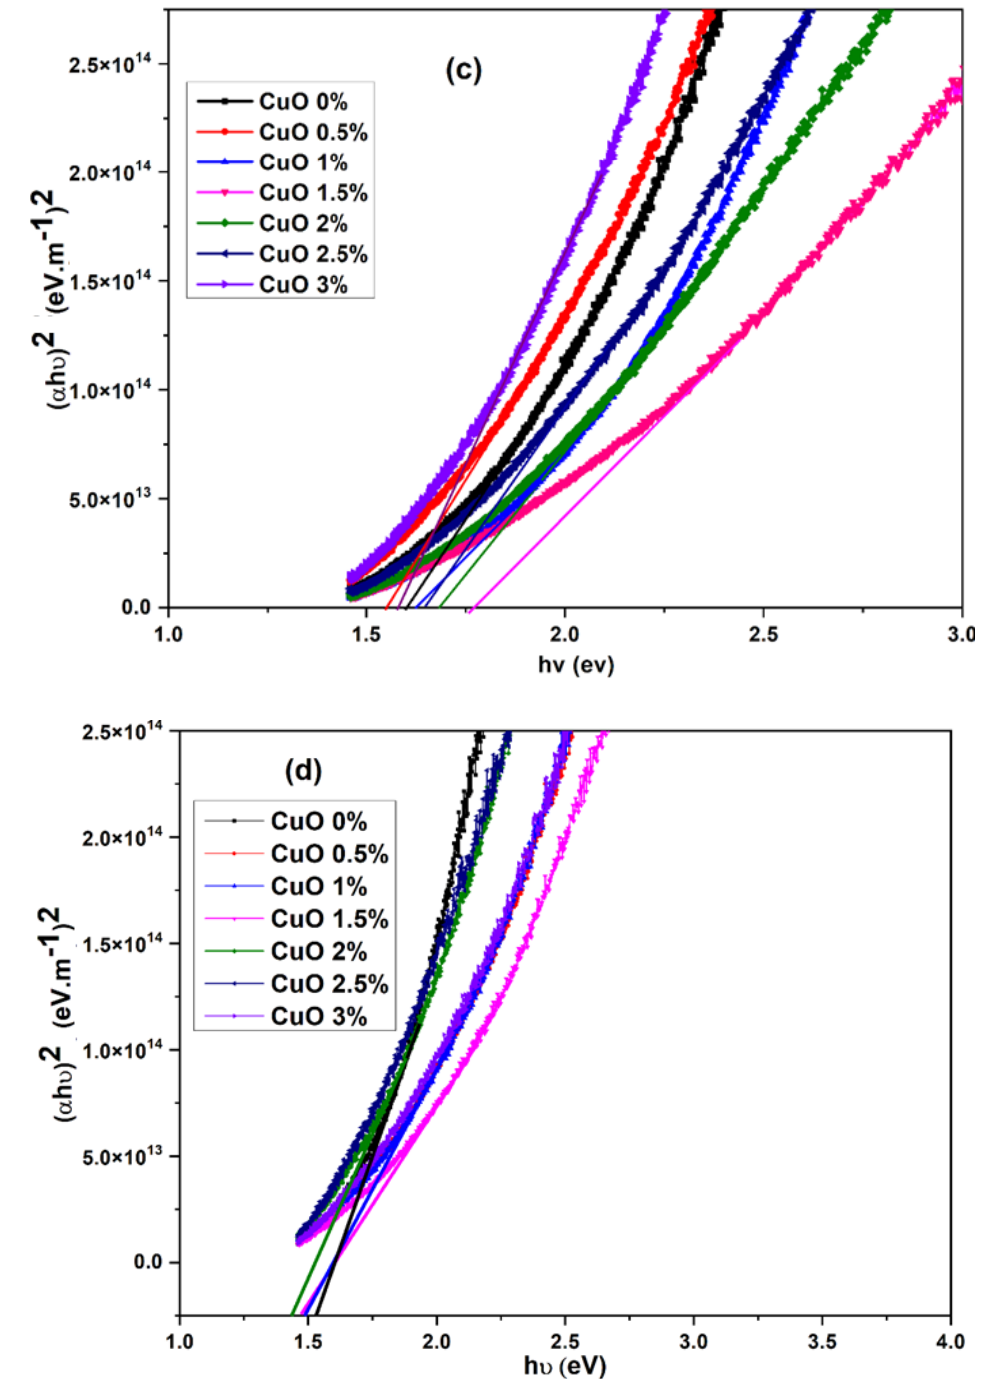
Figure 3. Optical properties for CuO films with various Sn concentrations. Optical transmittance spectra are shown in ( a ) for 5 layers, and ( b ) for 10 layers. Tauc plots (αhν) 2 versus hν are shown in ( c ) for 5 layers and in ( d ) for 10 layers.